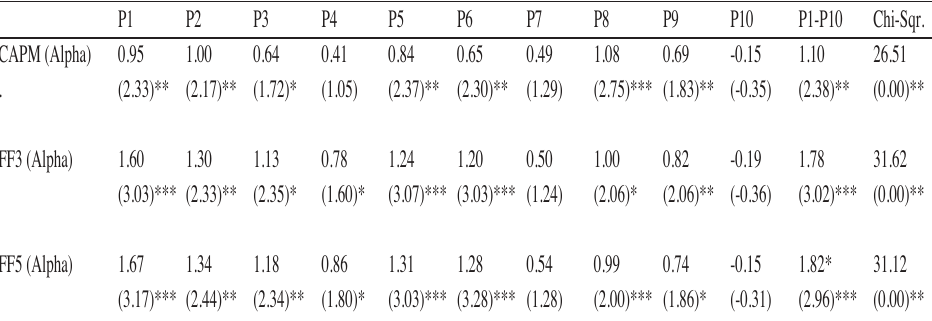
Table 2: Jensen Alpha of Equally Weighted (EW) Asset Growth Portfolio P1